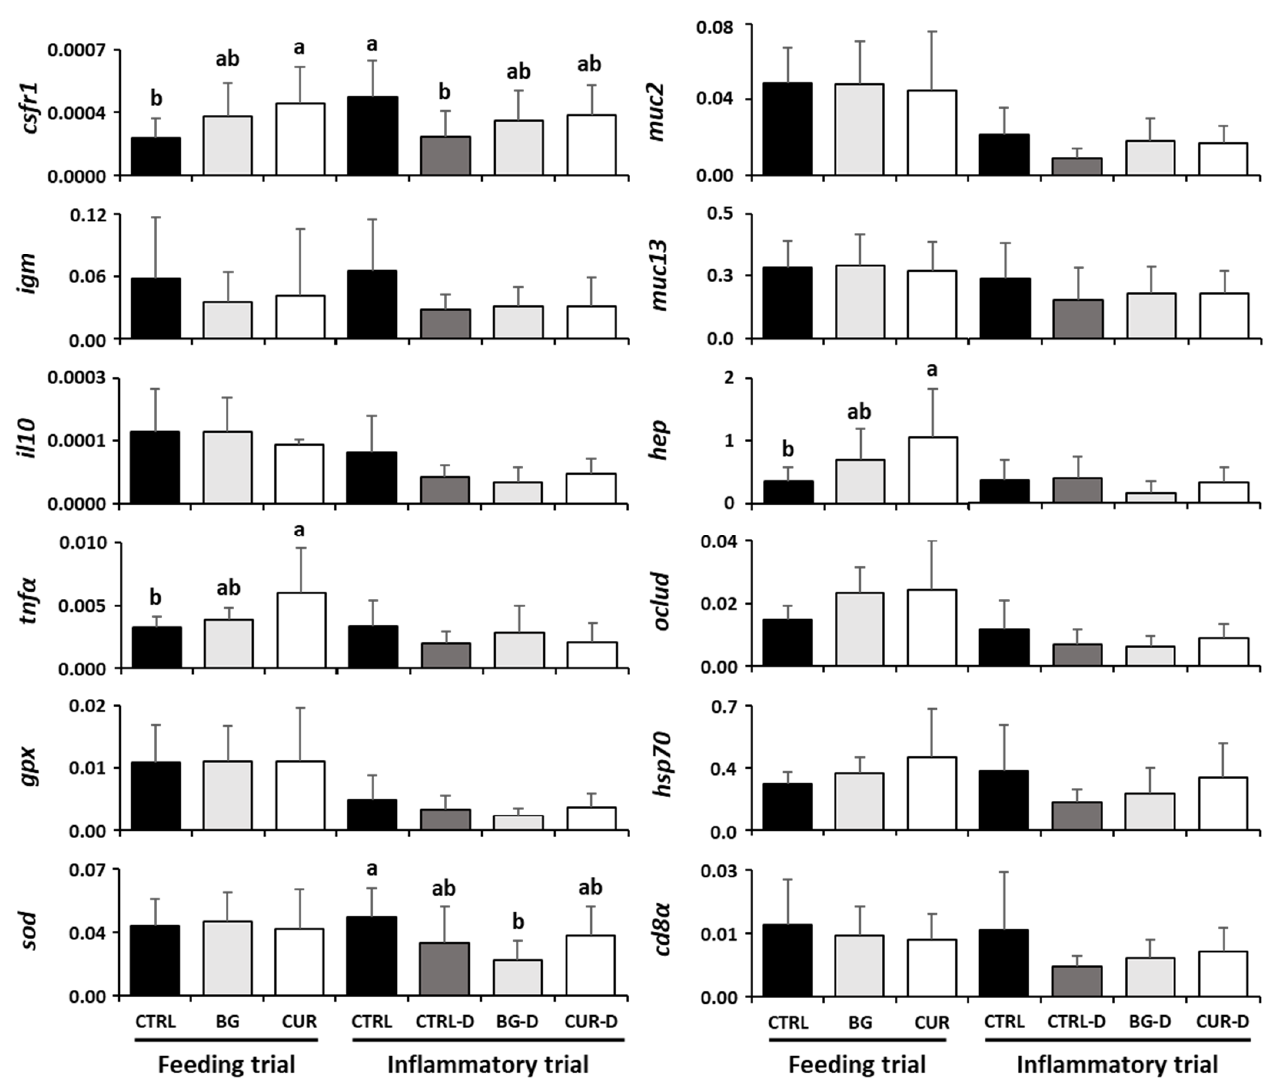
Figure 7. Intestinal gene expression profiles of gilthead seabream after the feeding and inflammatory trials ( n = 12). CTRL (control diet), BG (β-glucans diet), CUR (curcumin diet), CTRL-D (control diet + dextran sodium sulphate − DSS), BG-D (β-glucans diet + DSS), CUR-D (curcumin diet + DSS). Different letters mean significant differences among dietary treatments ( p < 0.05).